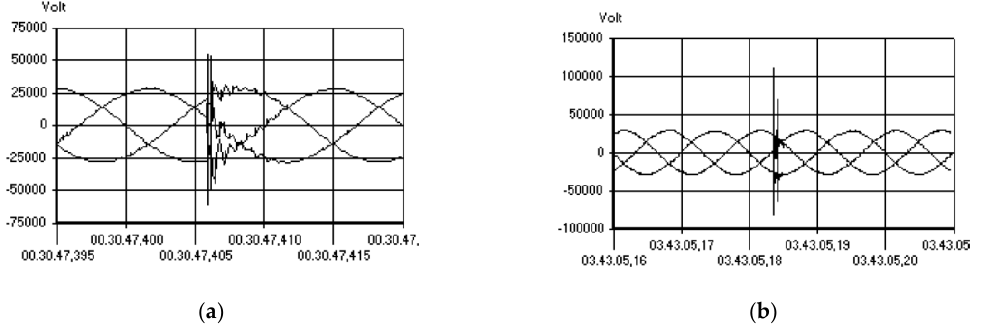
Figure 11. Measured two types of transient voltage in MV busbar of Rome subway system [101]. ( a ) Recorded type 1 transient voltage. ( b ) Recorded type 2 transient voltage.